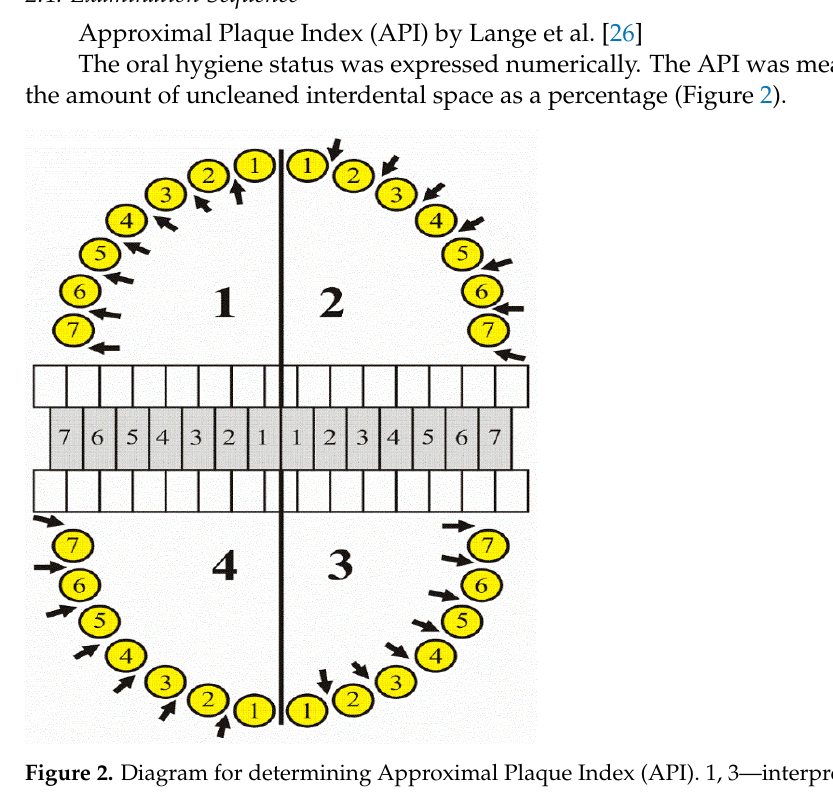
Figure 2. Diagram for determining Approximal Plaque Index (API). 1, 3—interproximal spaces are scored from the oral aspect; 2, 4—interproximal spaces are scored from the facial aspect. The evaluation criterion was the presence (+) or absence (-) of dental plaque on the